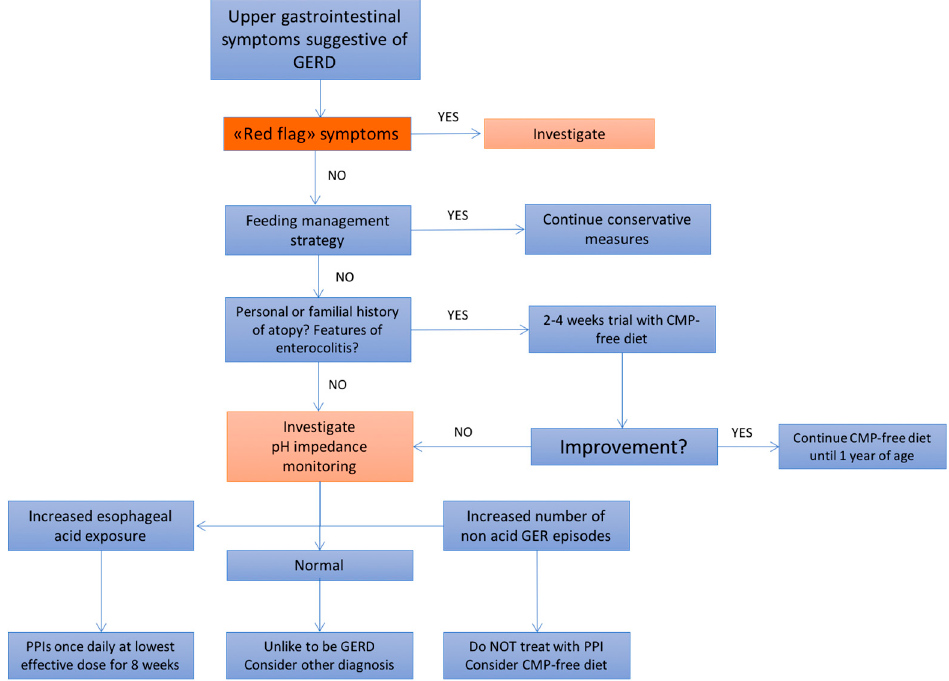
Figure 1. Flowchart of the clinical management of GERD in infants [11]. GERD: gastroesophageal reflux disease; GER: gastroesophageal reflux; CMP: Cow’s milk protein; PPIs: proton pump inhibitors.